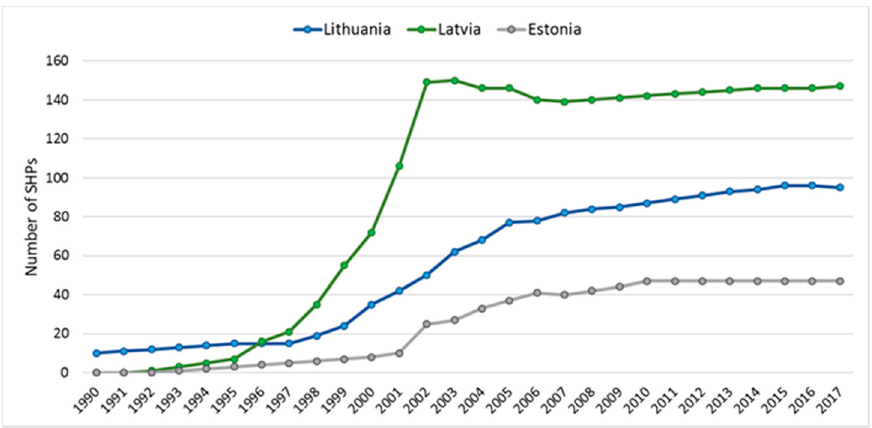
Figure 5. The growth in the number of small hydropower plants in the Baltic States. SHP: small hydropower